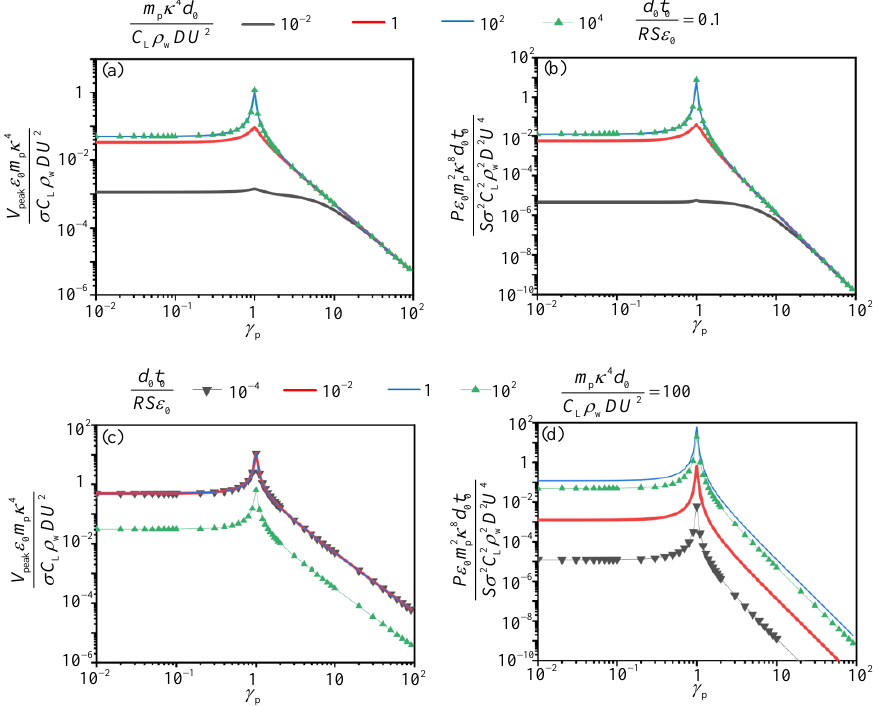
Figure 13. The normalized voltage V n2 and P n2 versus γ p . ( a , b ) are normalized voltage and power versus γ p with d 0 t 0 fixed; ( c , d ) are normalized voltage and power versus γ p with m p κ